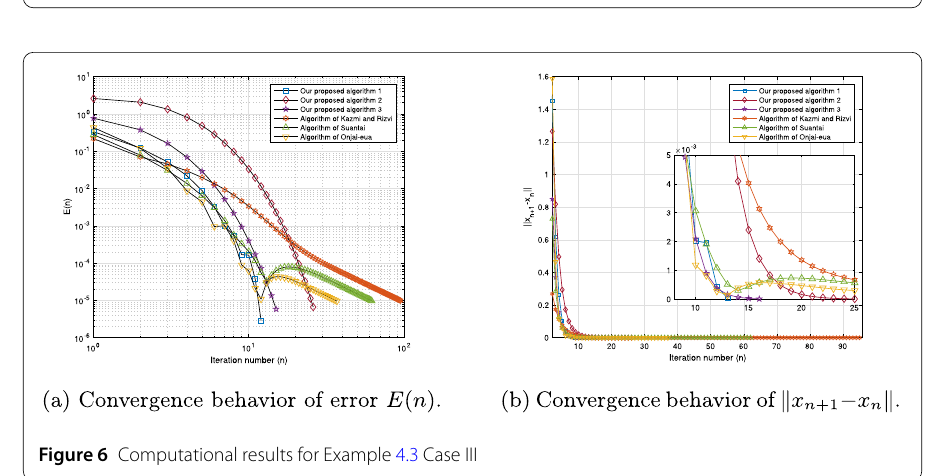
Figure 6 Computational results for Example 4.3 Case